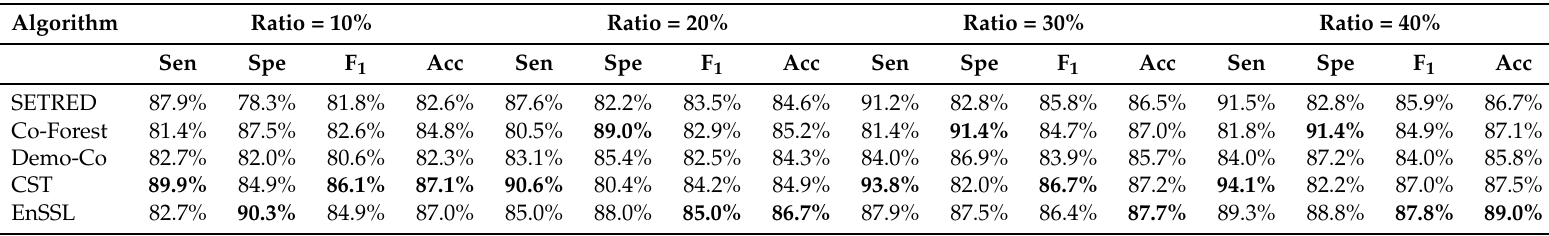
Table 6. Performance evaluation of SETRED, Co-Forest, Democratic-Co learning, CST-Voting and EnSSL on the Australian credit dataset.